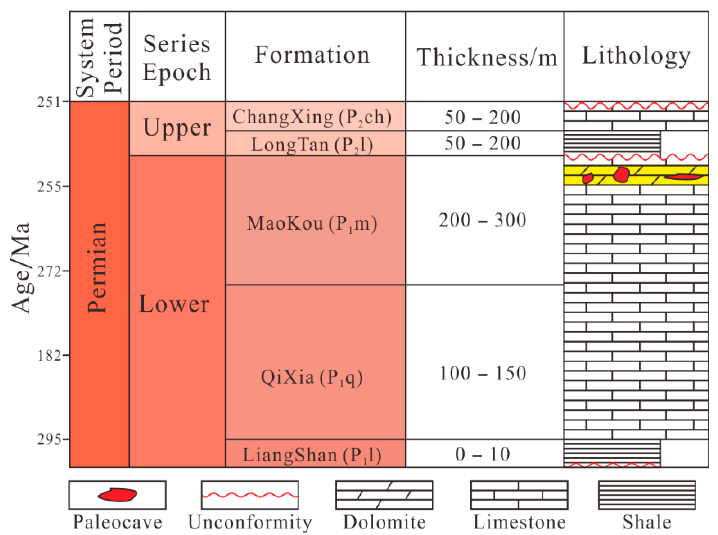
Figure 2. Comprehensive histogram of stratigraphic and lithological features of the Permian in the Sichuan Basin.